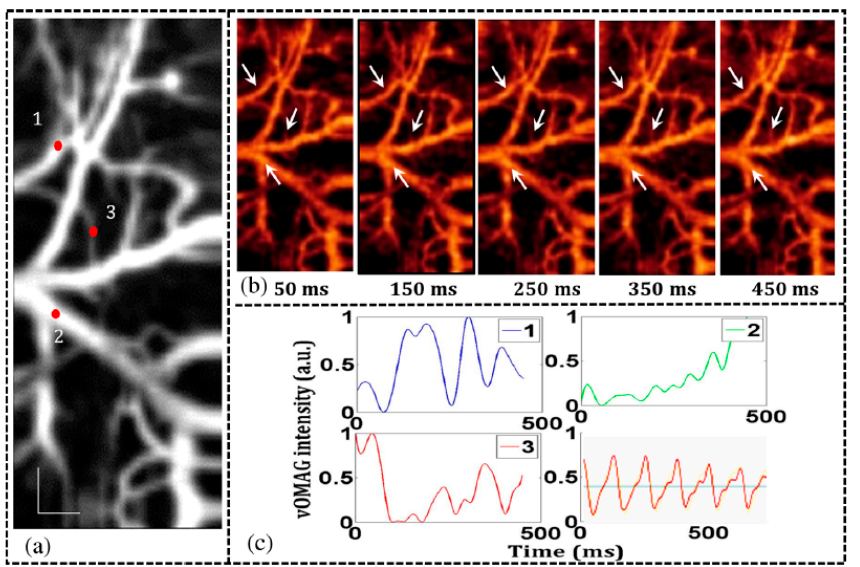
Figure 17. En-face view with sequential numbers indicating (1) an arteriole, (2) a venule, and (3) one of the smallest vessels, respectively. ( b ) Frames taken from the projected 4-D movie (visualization 1) to show time-varying blood flow dynamics. ( c ) OMAG signal variations (spline fitted) to show blood flow dynamics in the functional vessels that marked in ( b ) and sequentially numbered in ( a ). Reprinted with permission from Ref. [128].